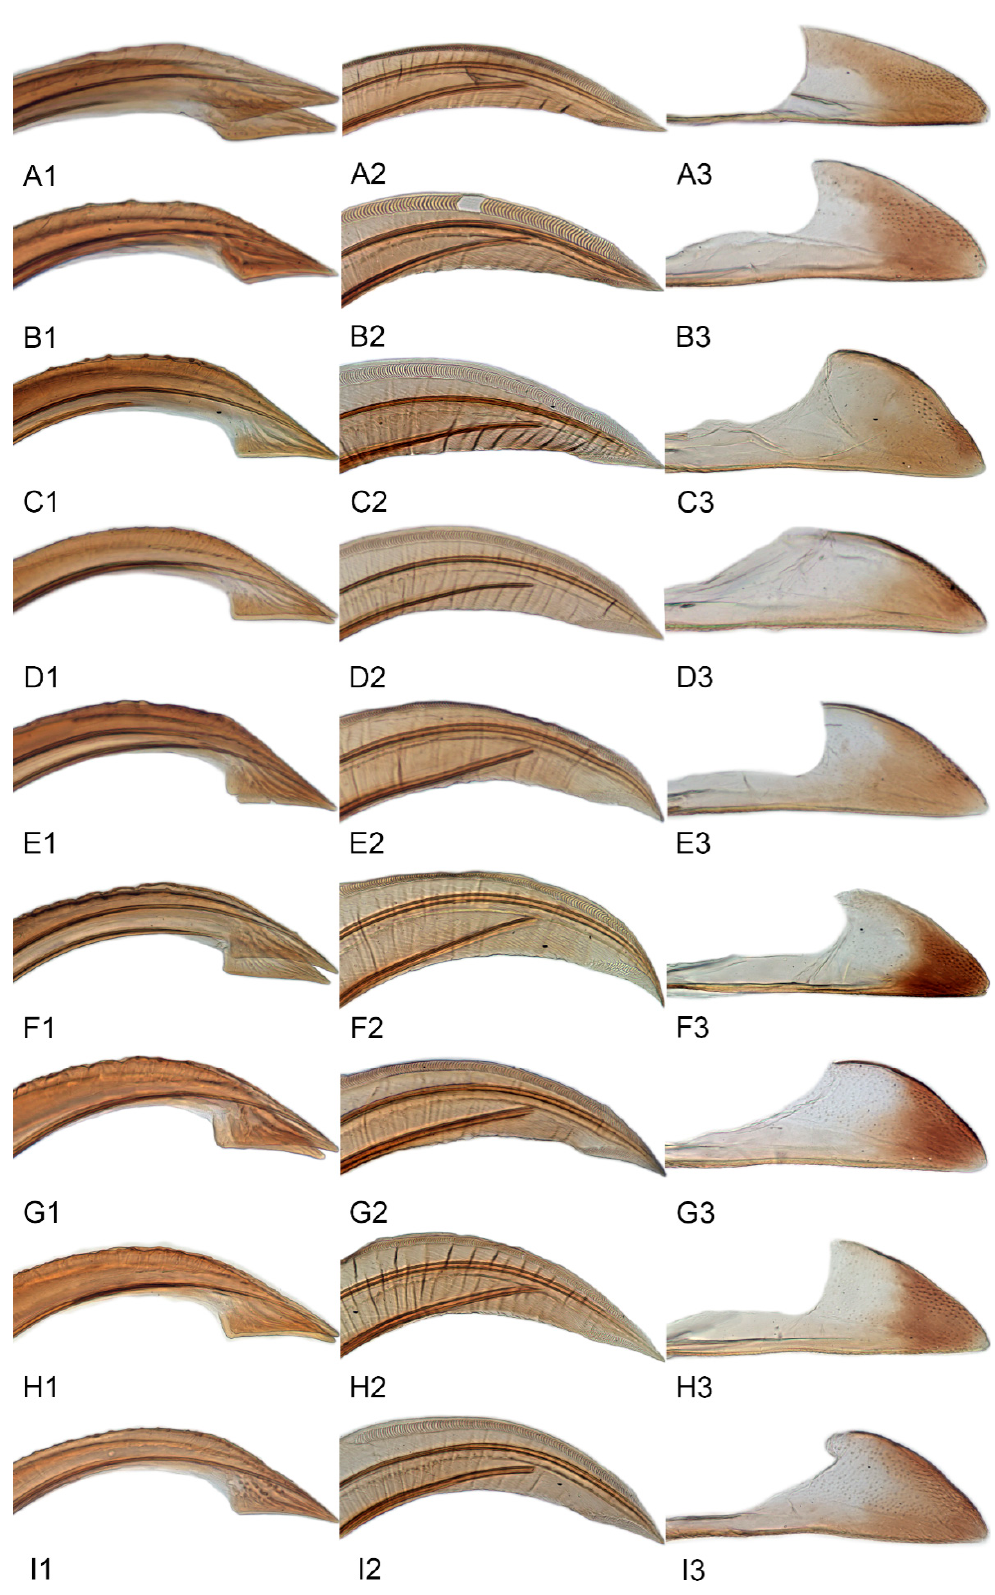
Figure 26. Dissected parts of ovipositor, showing detail of second, first and third valvulae apex. ( A1 – A3 ) X. chrysanthemum sp. nov.; ( B1 – B3 ) X. tenusis sp. nov.; ( C1 – C3 ) X. exproiecturus sp. nov.; ( D1 – D3 ) X. abyssinicus ; ( E1 – E3 ) X. cowboyocreus sp. nov.; ( F1 – F3 ) X. recipinams sp. nov.; ( G1 – G3 ) X. limpidissimus sp. nov.; ( H1 – H3 ) X. dimiprocessus sp. nov.; ( I1 – I3 ) X. malleus sp. nov.